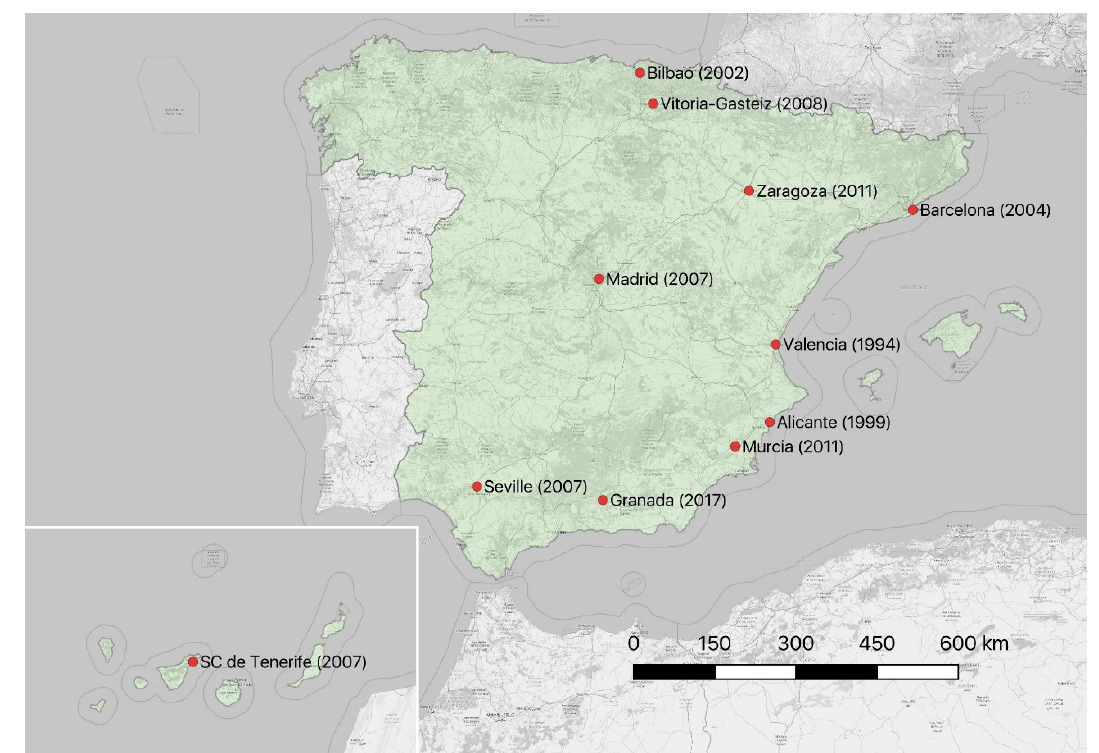
Figure 1. Cities with LRT and year inaugurated. Barcelona includes the Trambaix and Trambesòs systems; Madrid includes the Pozuelo, Boadilla, Sanchinarro and Parla systems.